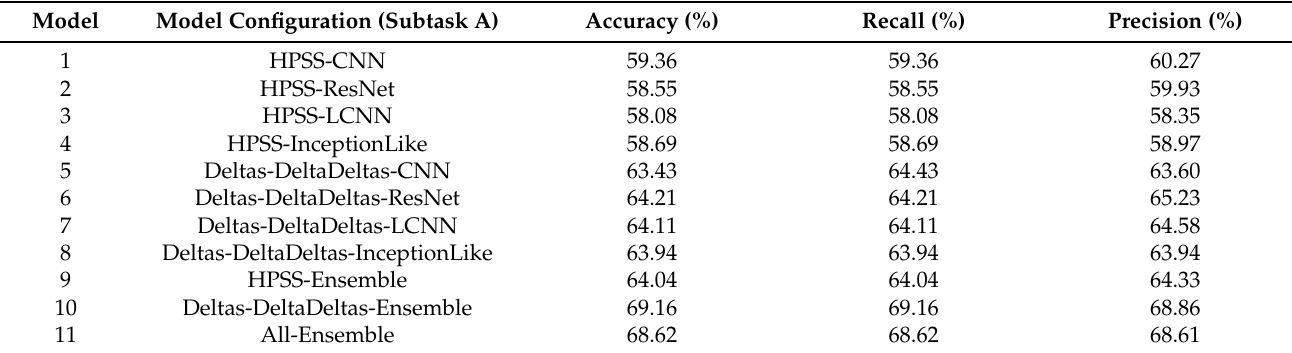
Table 1. Subtask A Results. Accuracy (%), recall (%) and precision (%) are multi-class accuracy, macro-averaged recall, and macro-average precision, respectively, of the development set.